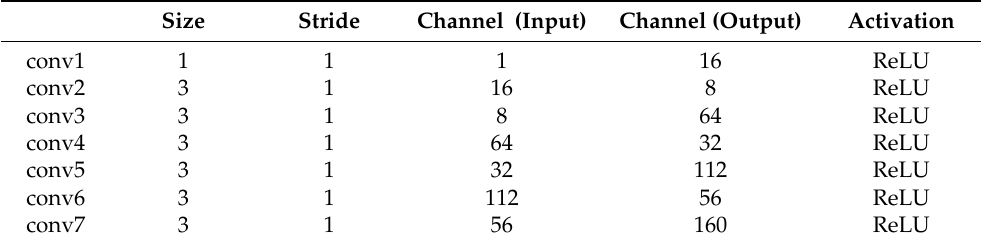
Table 1. The setting details of the encoder